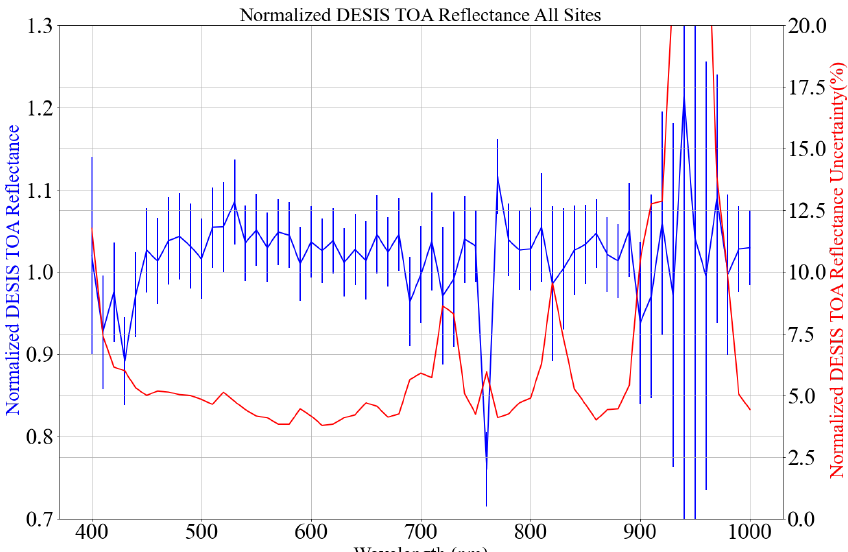
Figure 17. Mean and standard deviation of normalized DESIS TOA reflectance from all sites.